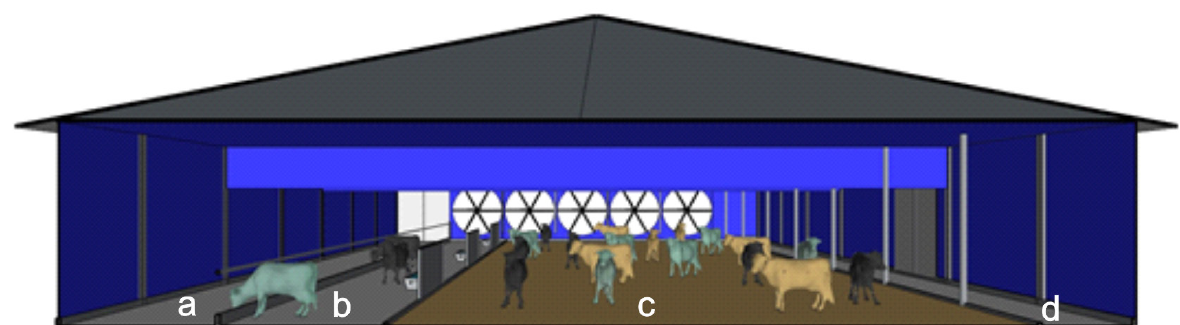
Figure 1. Schematic representation of the experimental facility. (a) drive-through alley; (b) feeding alley; (c) bedding area; (d) management corridor. Source: Andrade et al.